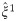
Phase portraits of the fast dynamics on the face Φ at three different ‘slow’ STD times.Stable patterns are coloured in green. The red trajectories are separatrices between the basins of attraction of the stable equilibria. The blue lines illustrate segments of a trajectory starting near ξ1. Box (1) panels (a,b,c) Phase portraits illustrate the mechanisms that can lead to transition ξ1 → ξ2 with excitable connections in Scenarios 1 as time evolves. (a) Trajectory starting near ξ1 converges to ξ1. (b) Trajectory follows the saddle between ξ1 and ξ^1 on the x1-axis. (c) Trajectory “jumps” out of the basin of attraction of ξ^1 under the effect of noise and converges towards ξ2 to ξ1. Box (2) panels (d,e,f) Phase portraits illustrate the mechanisms that can lead to transition ξ1 → ξ2 with excitable connections in Scenarios 2 as time evolves. (d) Trajectory starting near ξ1 converges to ξ1. (e) Trajectory remains in the basin of attraction of x1 defined by the saddle on the x1-axis. (f) Trajectory “jumps” out of the basin of attraction of ξ^1 under the effect of noise and converges towards ξ2.